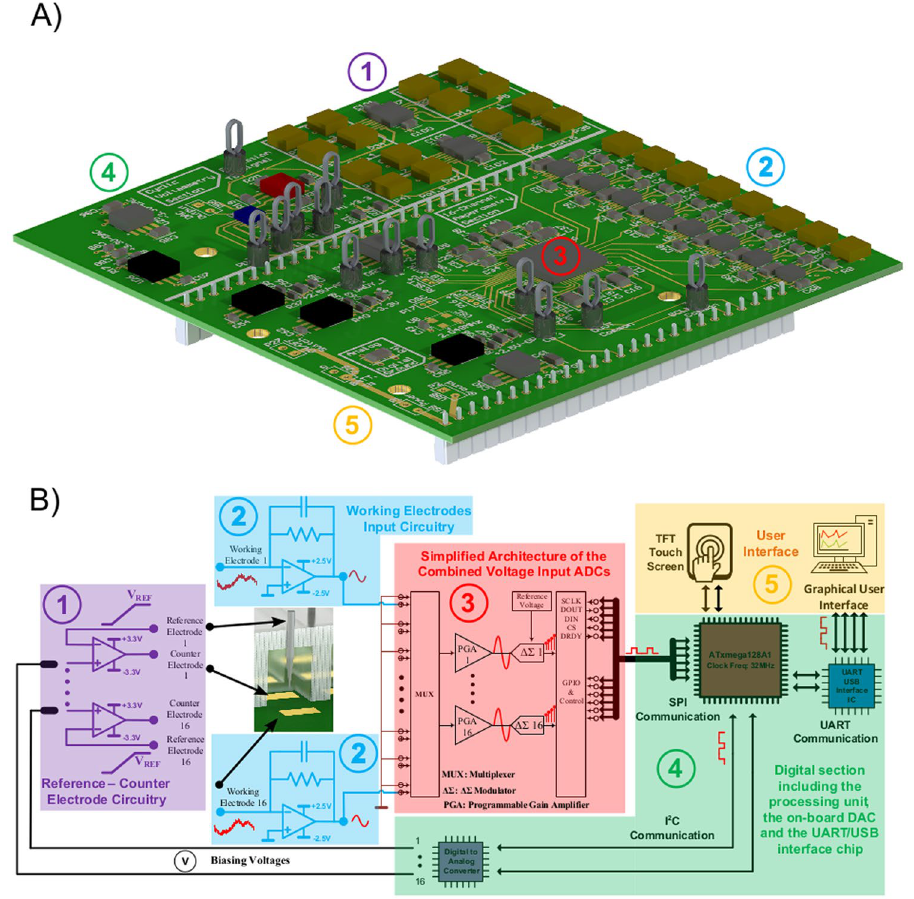
Figure 8. ( A ) A three-dimensional representation of the custom-made electronic board for sensitive amperometric measurements. ( B ) The individual compartments of the electronic board and their approximate location on ( A